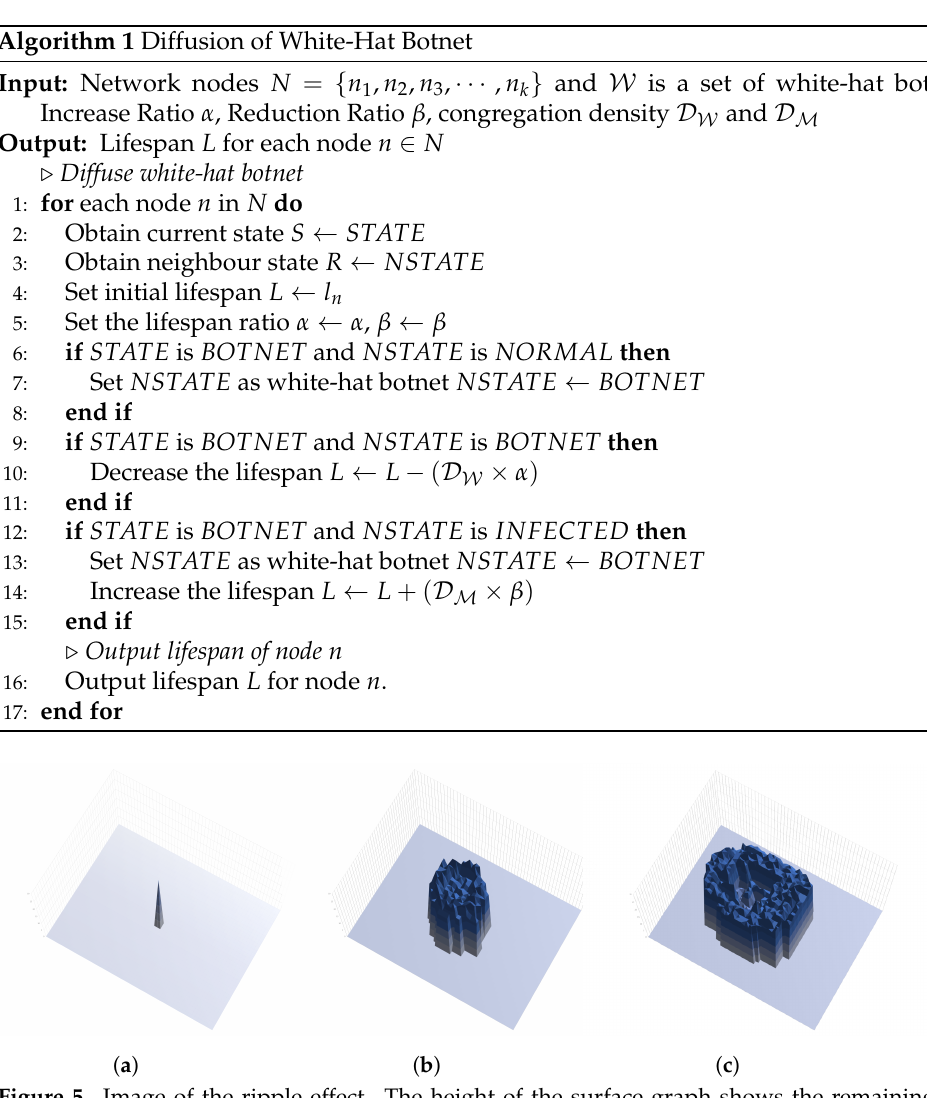
Algorithm 1 Diffusion of White-Hat Botnet